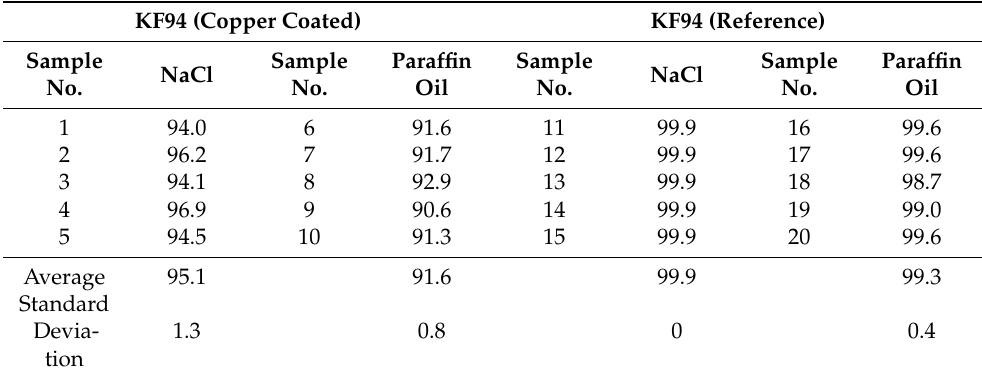
Table 1. NaCl and paraffin oil filtration performances of copper-coated and uncoated KF94 masks. KF94 (Copper Coated) KF94